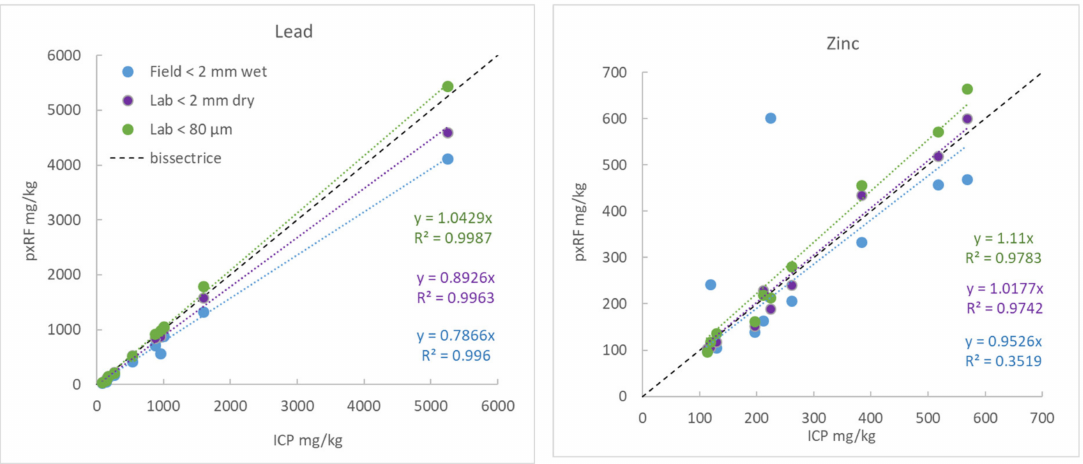
Figure 18. Analysis by pXRF of part dried and dried pellets, vs. laboratory analyses.